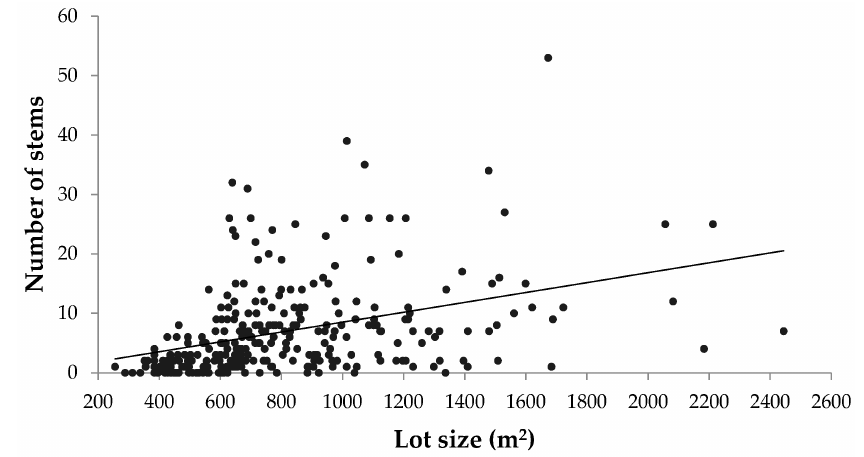
Figure A4. Correlation between private property lot size and number of stems found on each lot ( R 2 = 0.14, p < 0.05, 284 lots sampled in total).